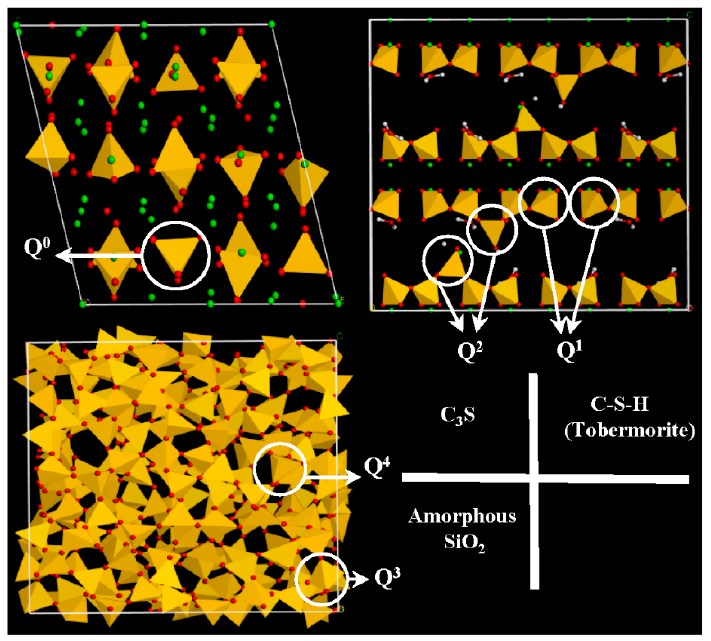
Figure 16. Molecular structure of C 3 S, C–S–H, amorphous SiO 2 , and different Q n in their structure.